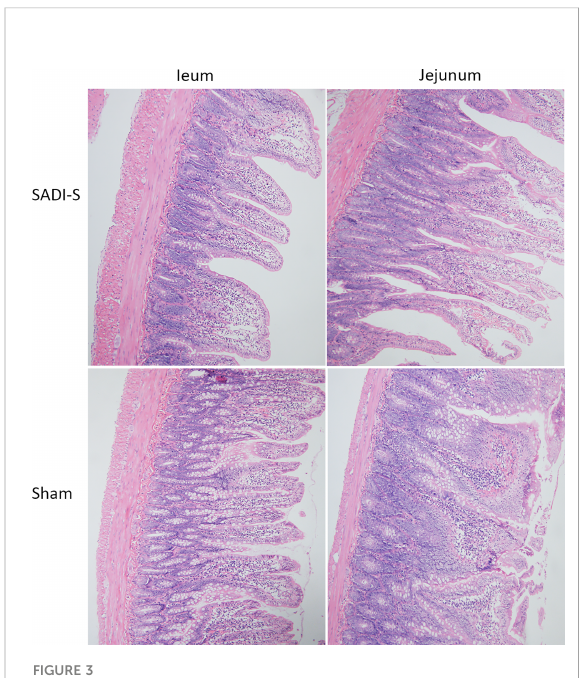
FIGURE 3 Hematoxylin and eosin (H&E) staining photographs. Morphological and histological evaluation of ileum and jejunum between the SADI-S group and the sham operation group (200×).